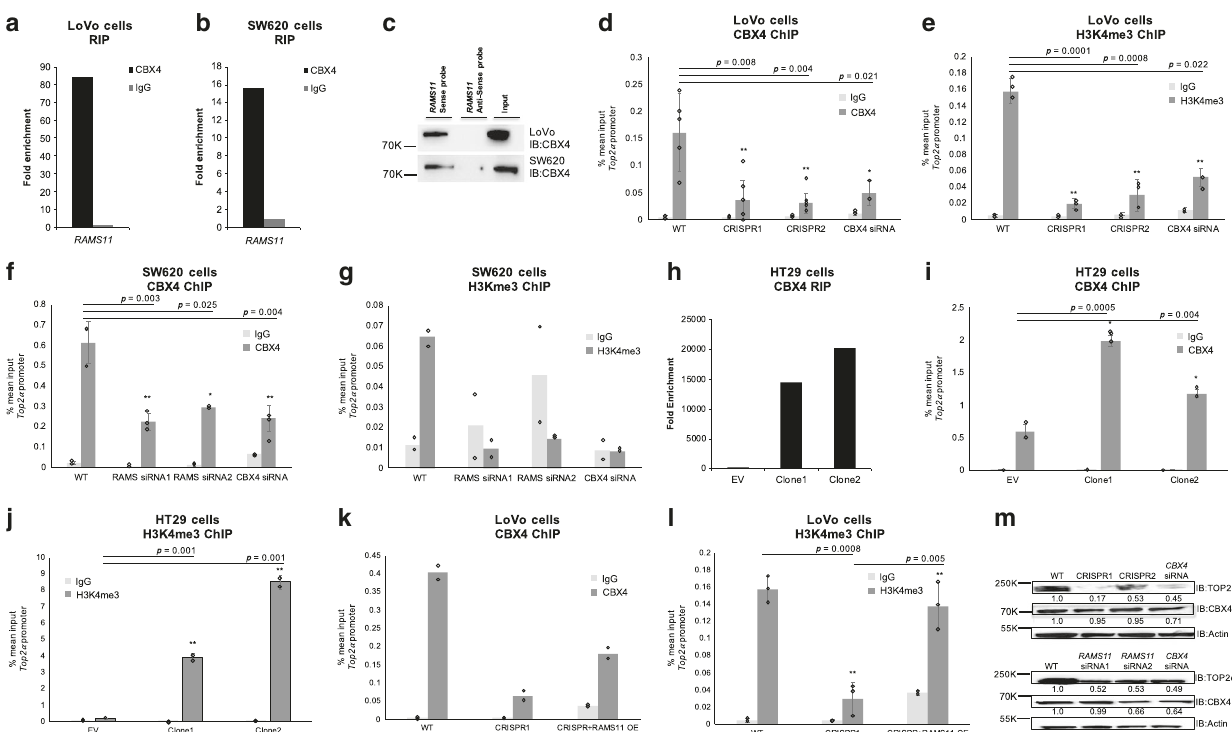
Fig. 7 RAMS11 binds to chromobox 4 (CBX4) to regulate expression of Top2 α mRNA and protein. RNA immunoprecipitation (RIP) shows binding of RAMS11 to CBX4 and not negative control IgG in a LoVo and b SW620 cells. c RNA pull down of 5-Bromo-UTP full-length RAMS11 probe showing binding of CBX4 by Western blot in LoVo and SW620 cells. d – g Decreased binding of CBX4 and active histone mark H3K4me3 at TOP2 α promoter with silenced RAMS11 expression in chromatin immunoprecipitation (ChIP) assay. IgG n = 2, CBX4 n > 3, H3K4me3 n > 2. h RIP showing increased binding of RAMS11 to CBX4 in HT29 RAMS11 overexpressing cells. i , j ChIP of CBX4 and H3K4me3 shows increased binding to TOP2 α promoter in HT29 RAMS11 overexpressing cells. IgG n = 3, CBX4 n = 3, H3K4me3 n = 2. k , l ChIP of CBX4 and H3K4me3 in CRISPR KO cells with RAMS11 overexpression (OE) rescue at TOP2 α promoter. IgG n = 2, CBX4 n = 2, H3K4me3 n = 3. m Protein expression of TOP2 α and CBX4 in LoVo (top) and SW620 cell lines (bottom). Band intensities were quanti fi ed from the digital image in ImageJ and are shown normalized to the wild-type lane for each target. Samples derived from the same experiment and blots were processed in parallel. Fold change normalized expression to actin is shown below gel. All data are presented as mean values ± s.d, analyzed by two-tailed paired t -test. Experiments repeated more than two times. * p < 0.05 ** p > 0.005, # p < 0.0005. Source data are provided as a Source Data